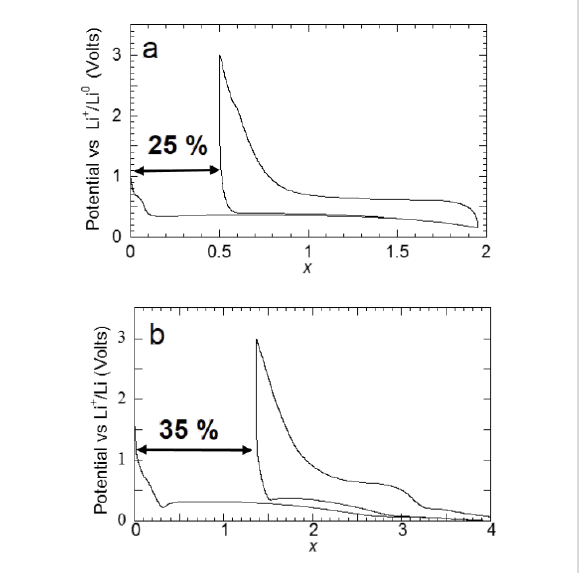
Figure 6: Potential profile of a MgH 2 electrode at various stages of the conversion reaction. a) Evolution of the potential (V) as a function of x for a Li/MgH 2 cell that was cycled down to x = 2 at a rate of one equivalent of lithium in 10 h. b) Evolution of the potential (V) as a func- tion of x for a Li/MgH 2 cell that was cycled down to x = 4 at a rate of one equivalent of lithium in 10 h. Adapted from [5] (copyright 2008 Nature Publishing Group) and [11].